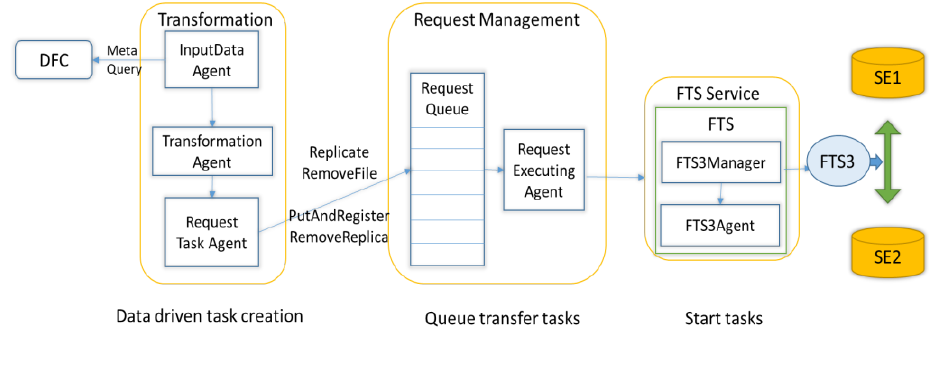
Fig. 6. JUNO dataflow